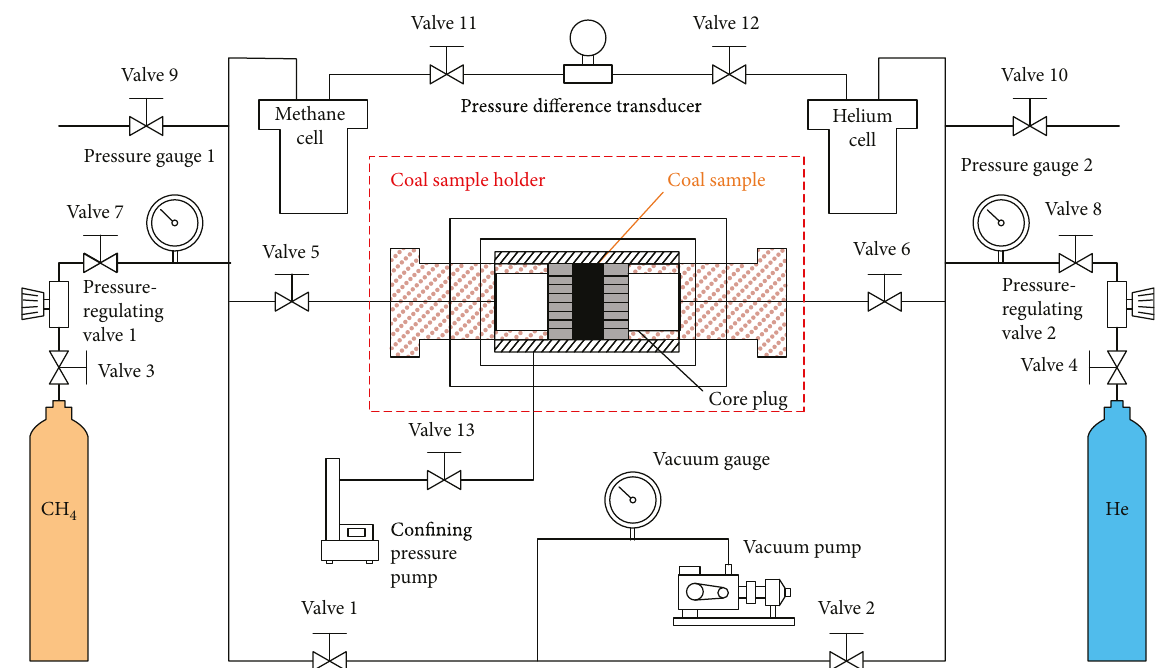
Figure 4: Schematic diagram of counterdi ff usion experiment modi fi ed from Dong et al. [39].